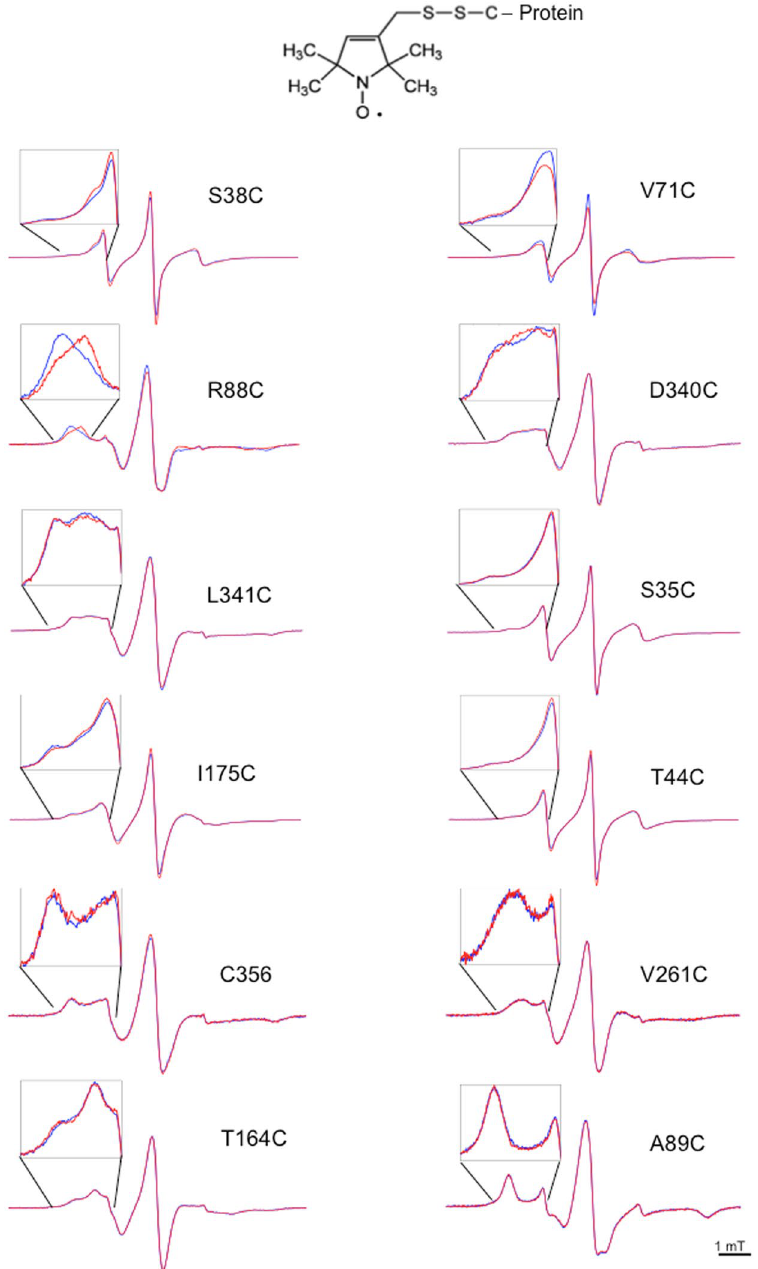
Figure 4. CW-EPR spectra of the 12 investigated mutants of HydF labeled with MTSSL, taken before (blue) and immediately after (red) addition of GTP. For each mutant, an enlargement of the low-field region is shown. Spectra are taken at room